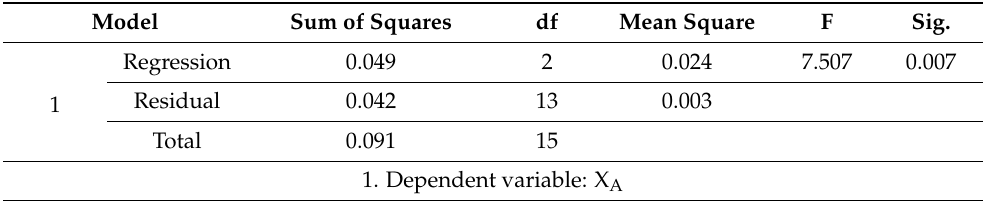
Table 12. ANOVA with two predictors.